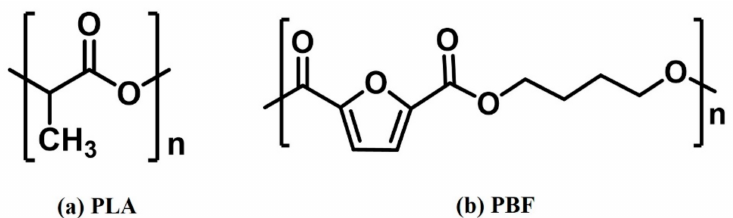
Figure 2. Molecular structure of ( a ) PLA and ( b ) PBF.